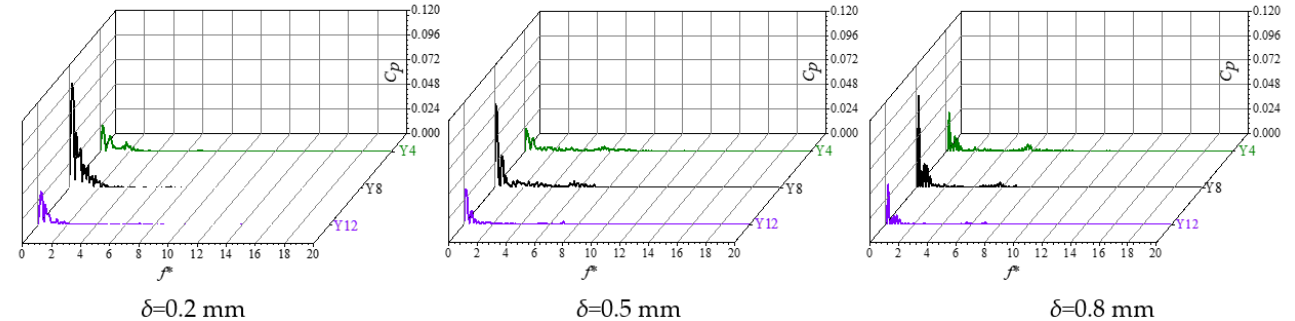
Figure 23. Frequency domain diagram of pressure fluctuation at impeller outlet monitoring point (Y4, Y8,